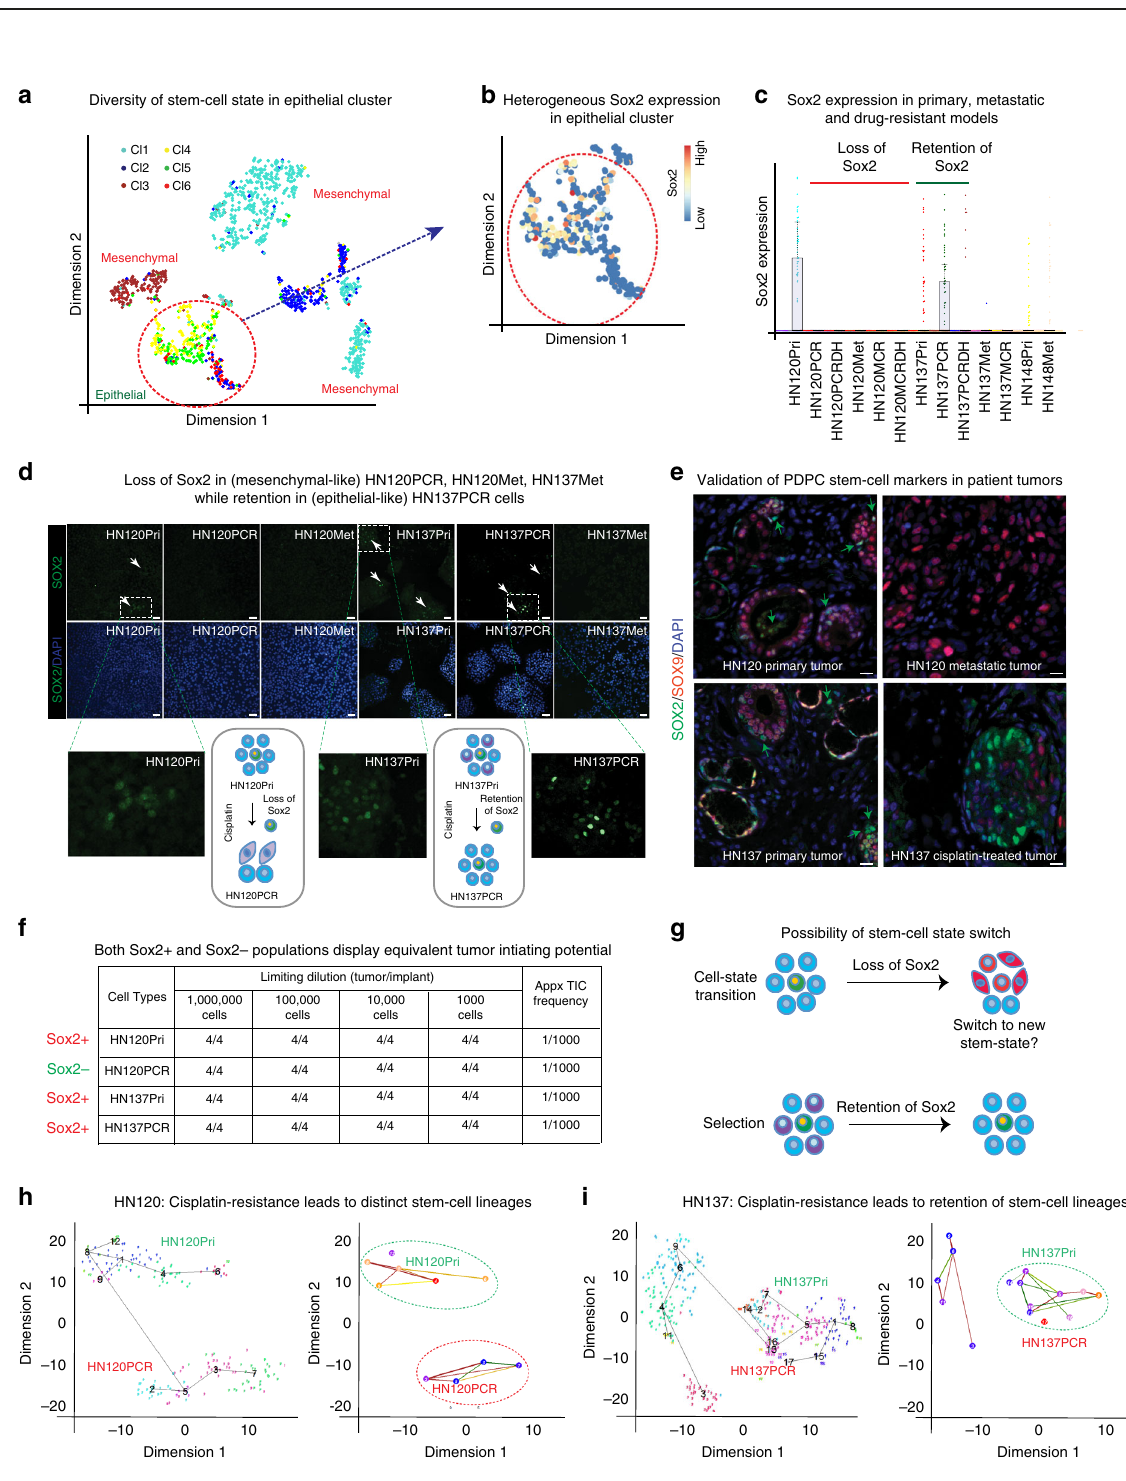
Fig. 3 Divergent developmental trajectories of drug-resistance in OSCCs. a , b Distribution of naive primary cells and their drug-resistant/holiday models on tSNE plots for HN120 ( a ) and HN137 ( b ). Note the switching of HN120 cells between distinct phenotypic clusters as they evolve from epithelial HN120Pri (cyan) to mesenchymal resistant HN120PCR (purple) and drug-holiday HN120PCRDH (dark-grey) cell states ( a ). Also note the heterogeneity within the HN137Pri population (spread of ‘ red ’ cell between two clusters), and the selective retention of the epithelial cell state in the HN137PCR resistant (dark green) and HN137PCRDH holiday model (dark red) ( b ). c Visualization of HN120, and HN137 naive metastatic cells, as well as their drug-resistant counterparts on tSNE. d Clustering of HN120 primary and metastatic drug-holiday model with intrinsically resistant HN148 cells. e PCA (basal/luminal genes) based hierarchical clustering of OSCC-PDPCs and their drug-resistant/holiday models with PAGODA, note the retention of basal/epithelial properties in HN137PCR, while gain of mesenchymal gene-signature in